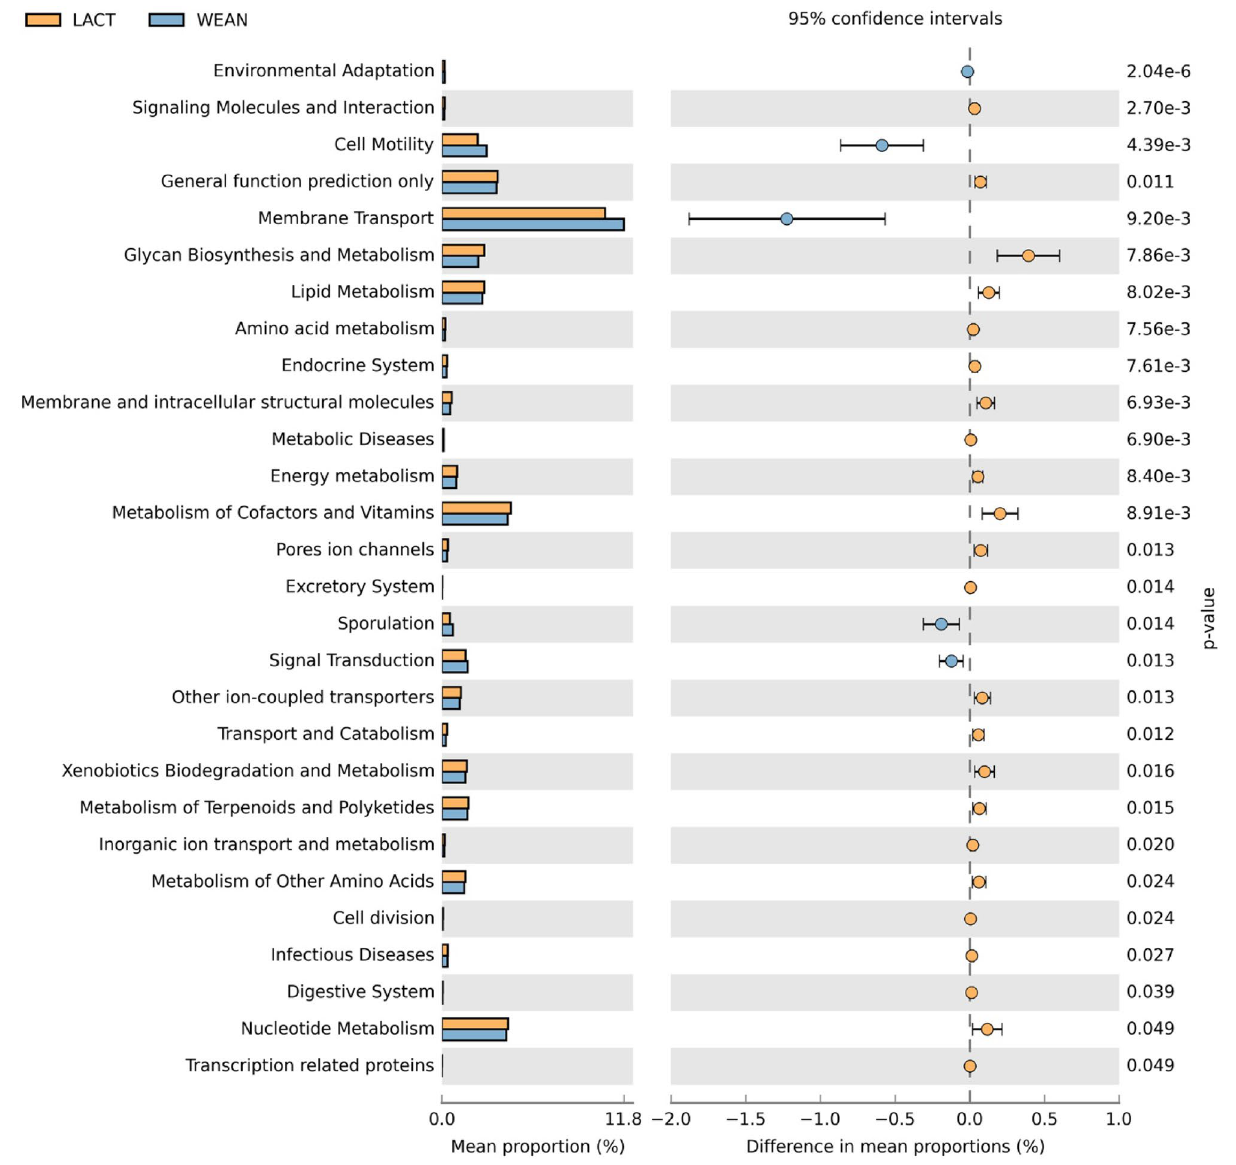
Figure 4. Significant differing caecal microbiota pathways between suckling and weaned piglets (KEGG level 2). All sequence reads were used to predict functions against the KEGG database 19 (http:// www. genome. jp/ kegg/) by means of PICRUSt 18 v.1.1.3. (http:// picru st. github. io/ picru st/) bioinformatics software